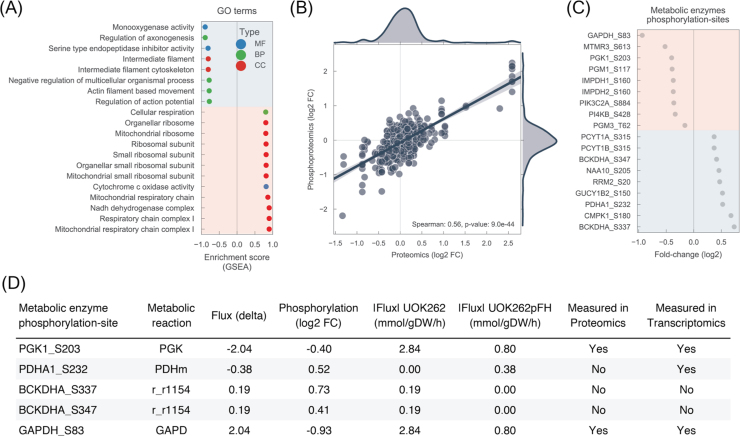
Post-translational regulation of metabolism in FH-deficient cells. A) Top significantly enriched GO terms found in the proteomics data-set (UOK262 - UOK262pFH). Red background denotes GO terms that are down-regulated and blue background denotes up-regulated. MF: molecular function; CC: cellular component; BP: biological process. B) Correlation between proteomics and phosphoproteomics measurements. C) Phosphorylation-sites located in metabolic enzymes for which the protein abundance is either not changing significantly or it was not measured. D) List of putative regulatory phosphorylation-sites in metabolic enzymes. Candidates were selected from C) and sorted by the metabolic flux change (flux delta). The top 5 absolute metabolic flux changes are shown. (For interpretation of the references to color in this figure legend, the reader is referred to the web version of this article.)